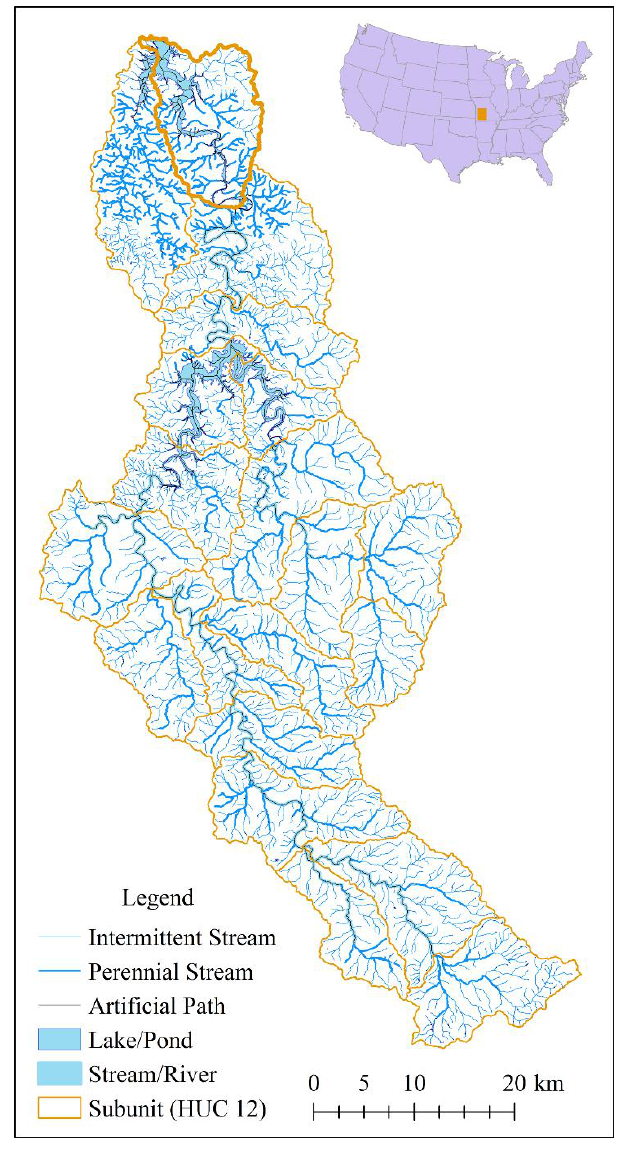
Figure 3. The source dataset of the